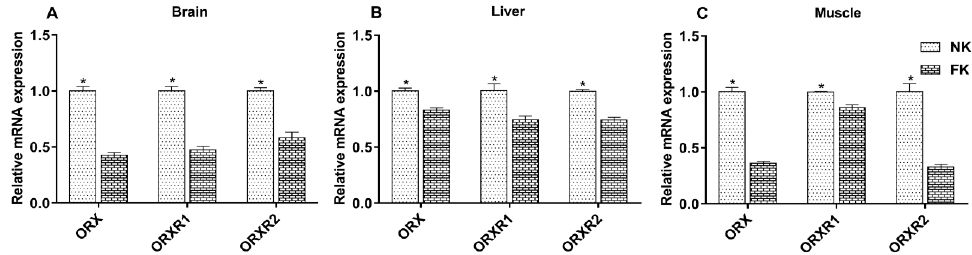
Figure 6. Expression of ORX , ORXR1 , and ORXR2 mRNA in the brains ( A ), livers ( B ), and muscles ( C ) of laying hens with normal keel (NK) or fractured keel (FK). * p ≤ 0.05.